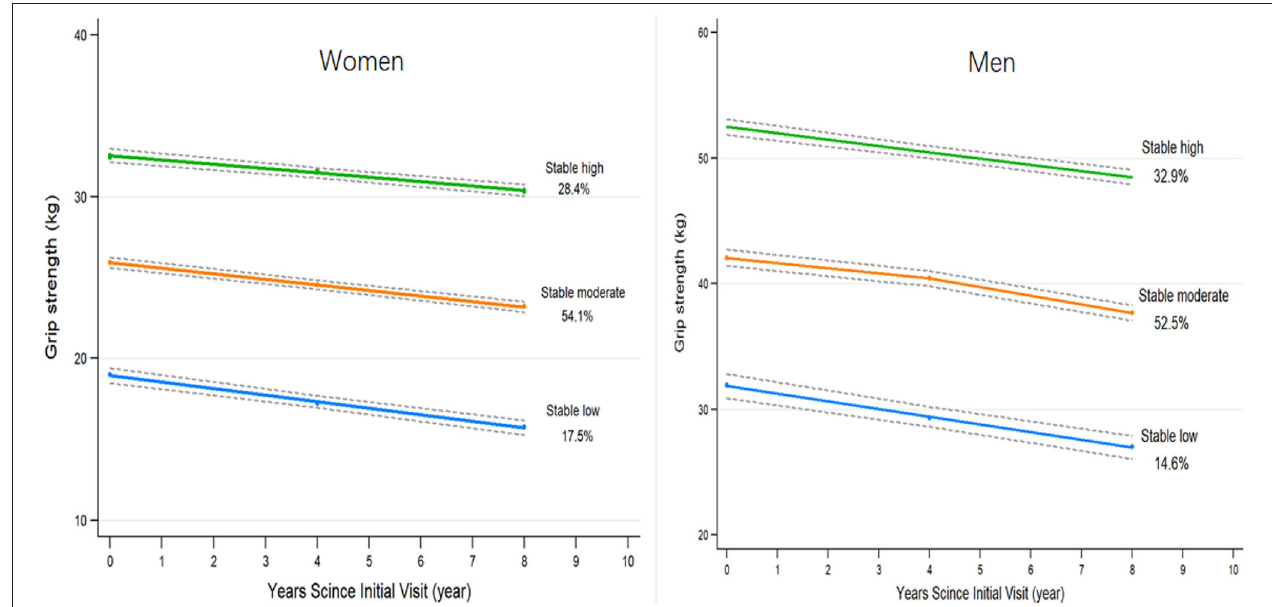
FIGURE 2 | The trajectories of grip strength by sex predicted with 95% confidence intervals. Three groups are indicated by stable high (green), stable moderate (orange), and stable low (blue). Percentages represent the proportion of the cohort with the corresponding group number as the highest predicted posterior